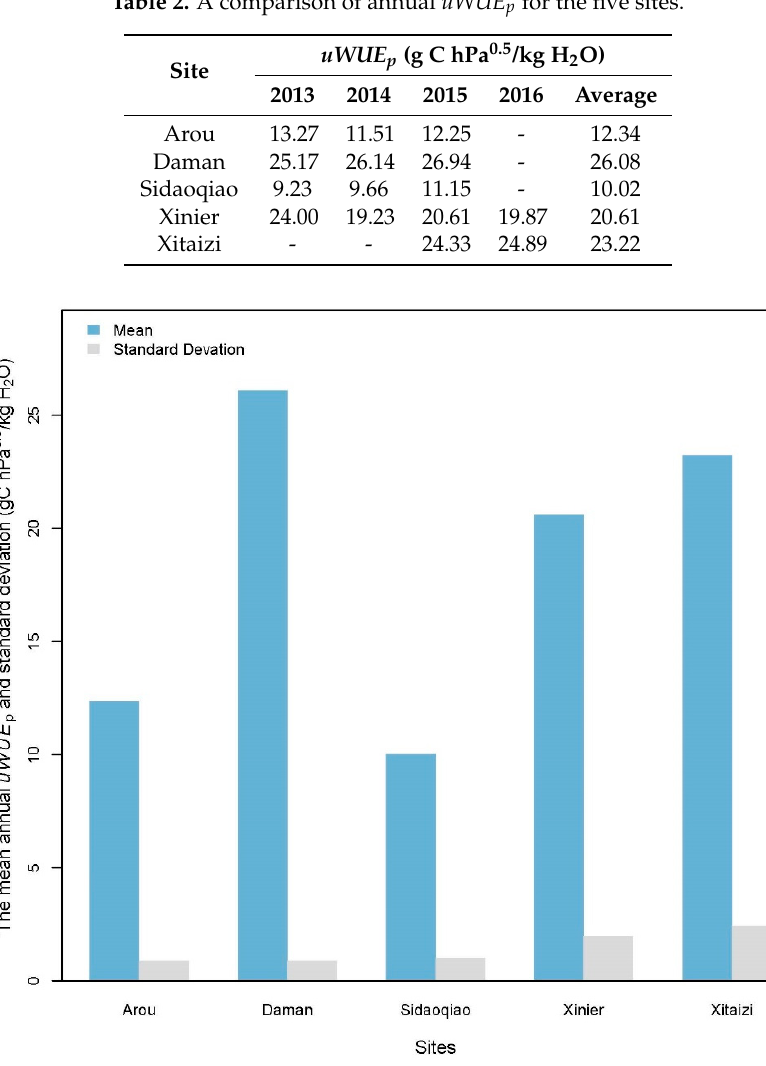
Figure 6. Annual uWUE p for the five sites.